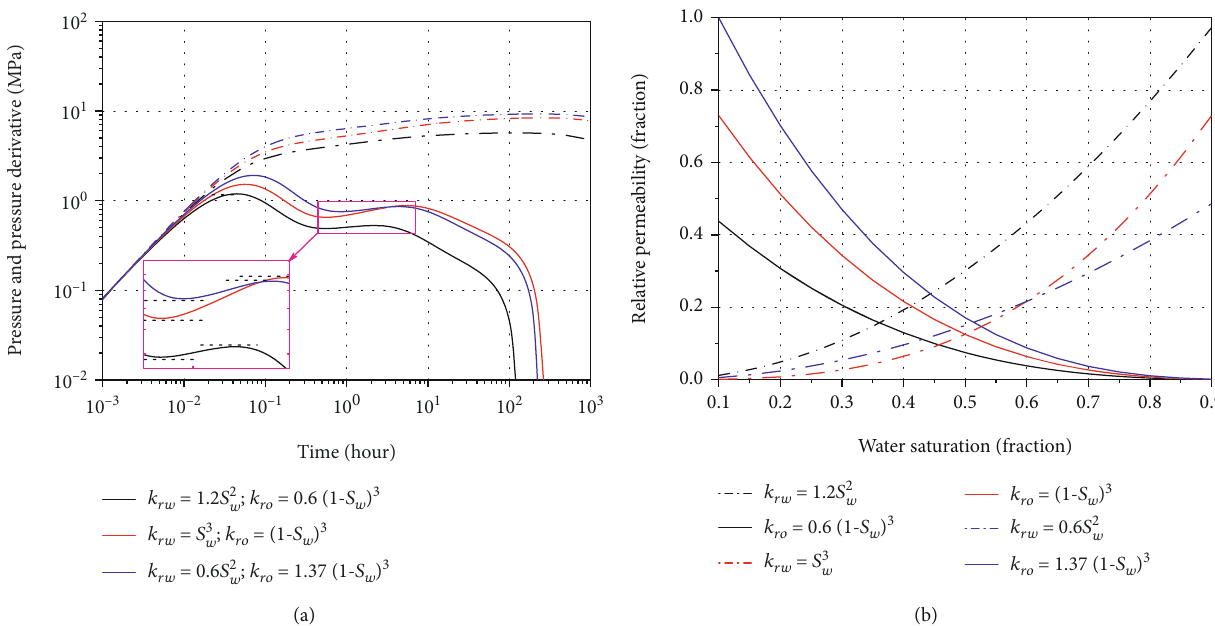
Figure 14: E ff ect of type of relative permeability on pressure transient response: (a) pressure transient response of the testing well with three di ff erent types of relative permeability; (b) three di ff erent types of relative permeability.